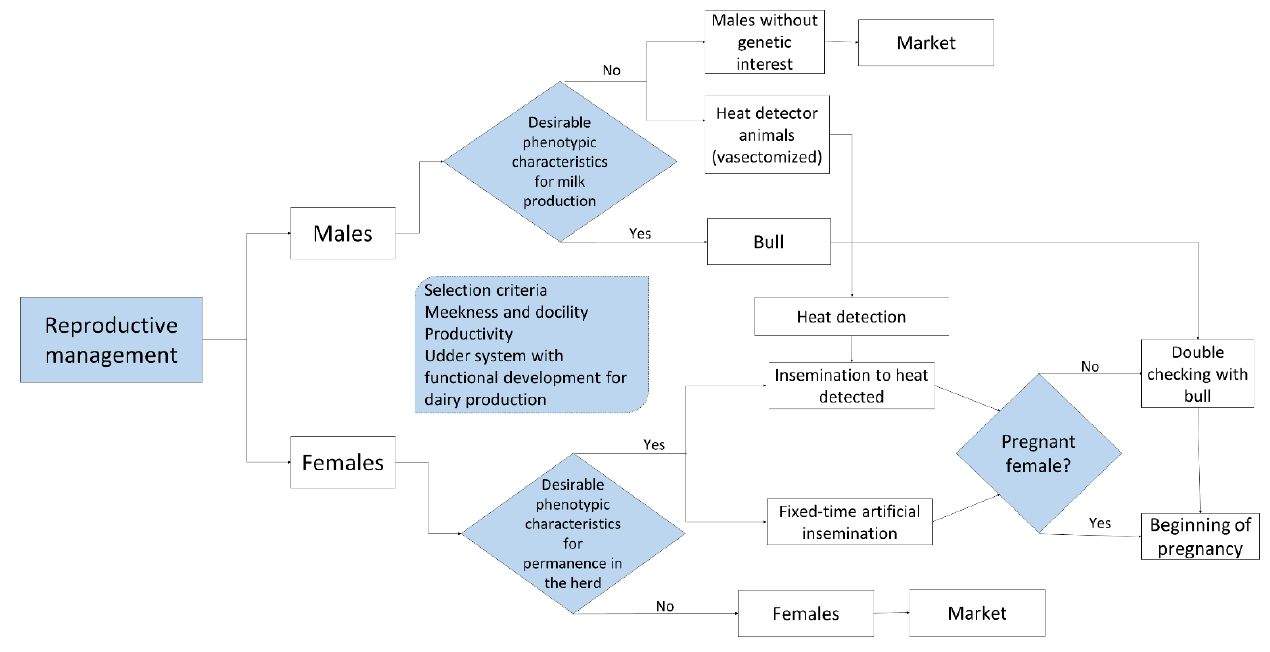
Figure 2. Reproductive management in the dual-purpose production system of water buffalo housed in the humid Mexican tropics.